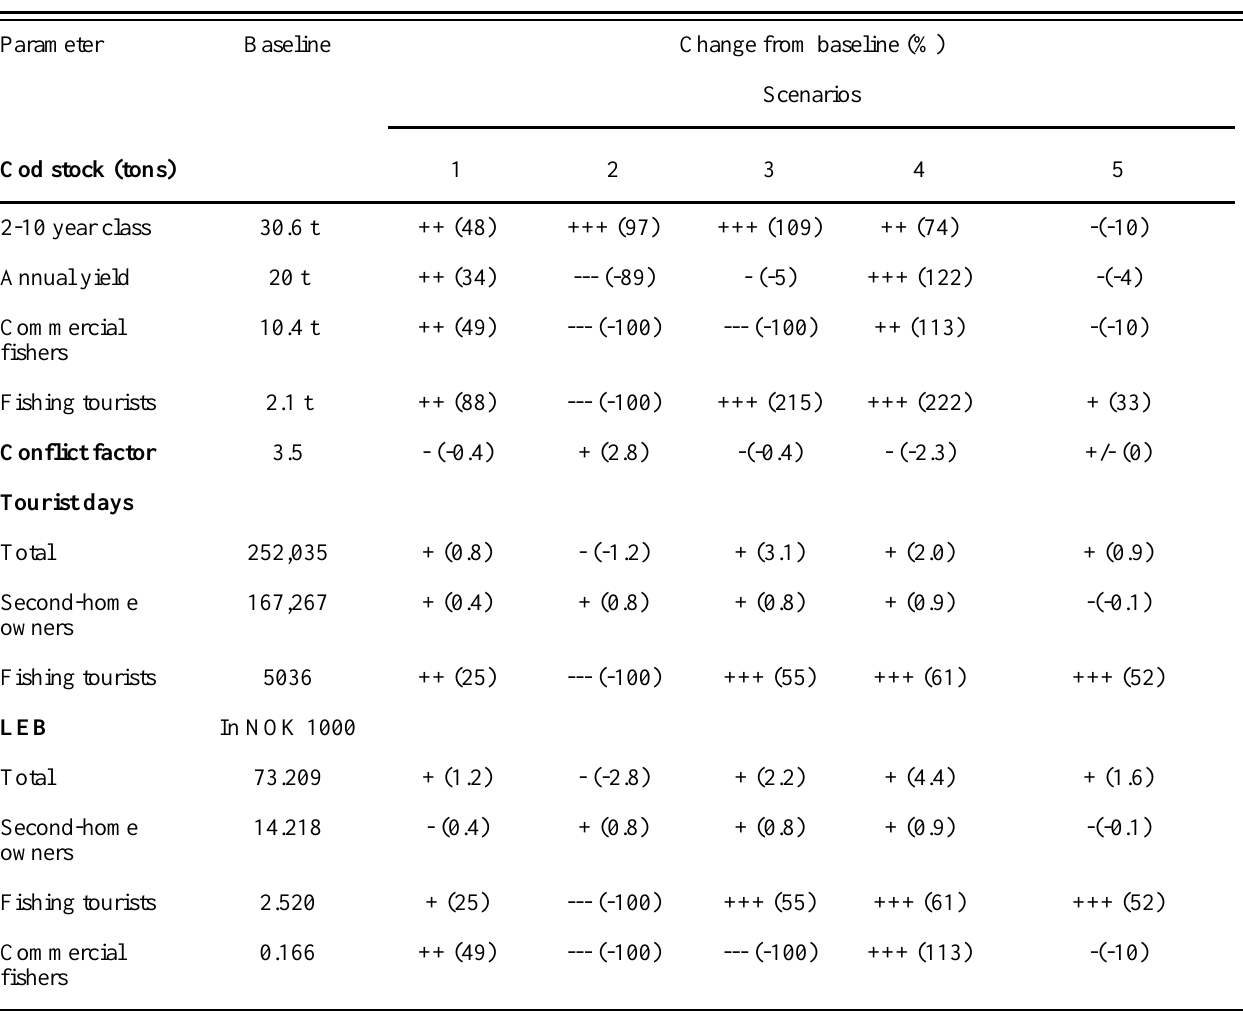
Table 3. Expected change (semiquantitative grading) in the dependent variables from baseline condition, based on model-runs where the independent variables are specified in five management scenarios. Grading: ‘not important’ (+/-), ‘important’ (++/--) , and ‘very important ‘ (+++/---). In scenario 2 and 3 the cod stock (2-10 year-classes) are only allowed to approximately double its biomass. (NOK = Norwegian kroner; 1 € is approximately 8 NOK; LEB = local economic